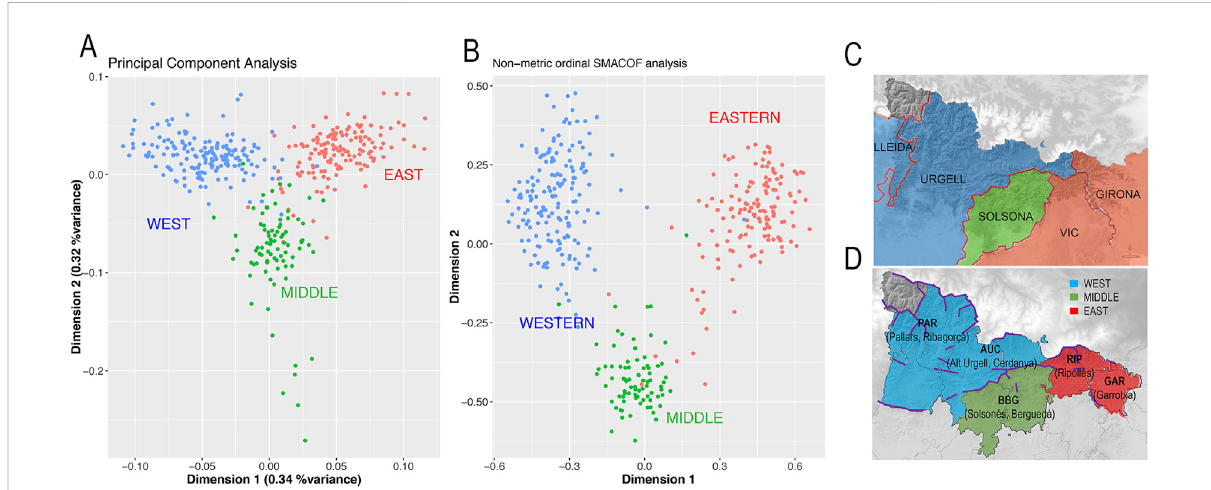
FIGURE 4 (A) FirsttwoPCs, explaining 0.6%ofvarianceofaPCAofGENPIRindividuals. (B) First twodimensionsoutofthefour-setobtained byprojecting an IBD matrix between pairs of individuals using an ordinal SMACOF analysis (stress = 0.4). GENPIR samples are assigned to three catalan Pyrenees regions according to their centroid assignment. (C) Map denoting assignment of bishoprics at each region: WEST (blue, bishoprics of Lleida and Urgell); MIDDLE (green, bishopric of Solsona); EAST (red, bishoprics of Vic and Girona). (D) Map denoting assignment of comarques at each region: WEST (blue, comarques of Pallars, Ribagorça, Alt Urgell and Cerdanya); MIDDLE (green, comarques of Solsonès and Berguedà); EAST (red, comarques of Ripollès and Garrotxa). In d, purple line denotes main orographic